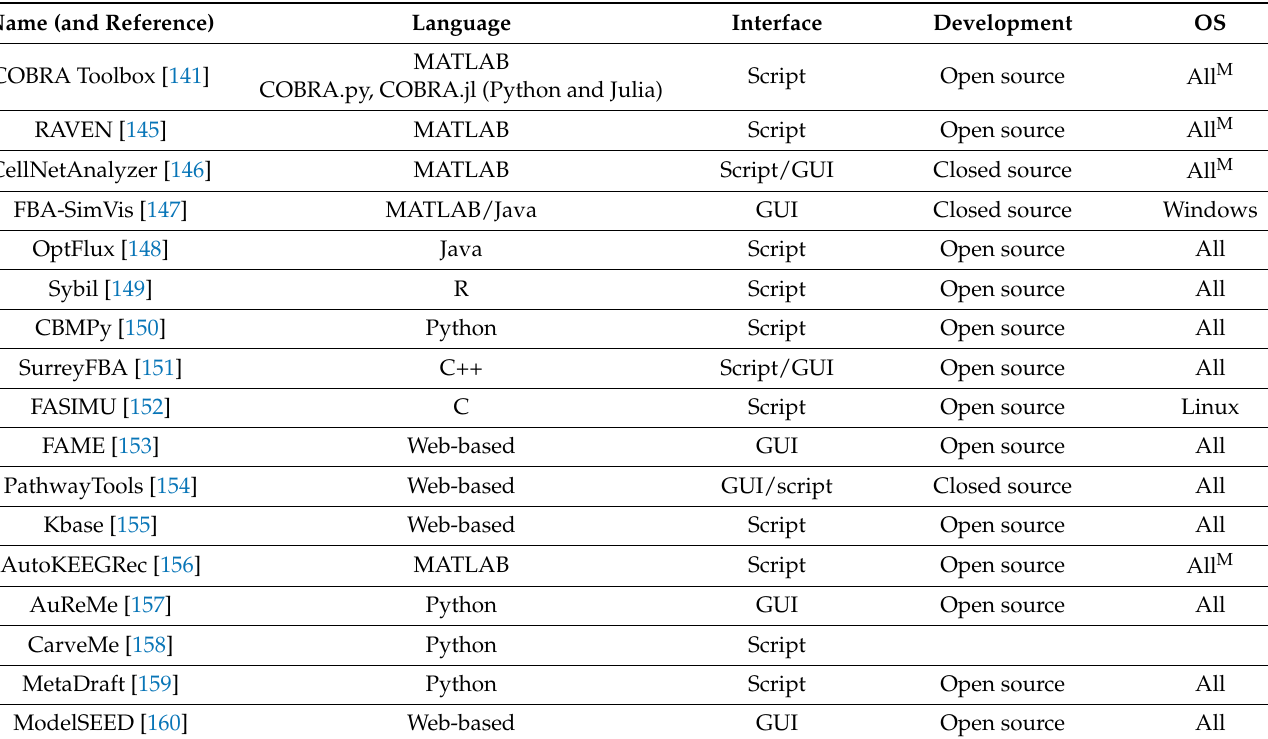
Table 2. Software applications for constraint-based modeling and/or genome-scale metabolic reconstruction. In References [141,144], all of these tools are reviewed in more